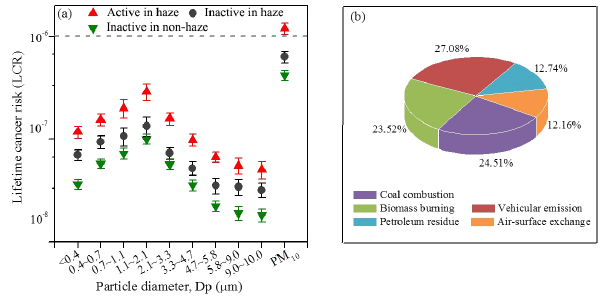
Figure 12. Panel (a) : lifetime cancer risk (LCR) due to exposure to the size-segregated PAHs through inhalation for inactive and ac- tive people during haze and non-haze period. Panel (b) : source con- tribution to accumulation mode PAHs during haze period by PMF